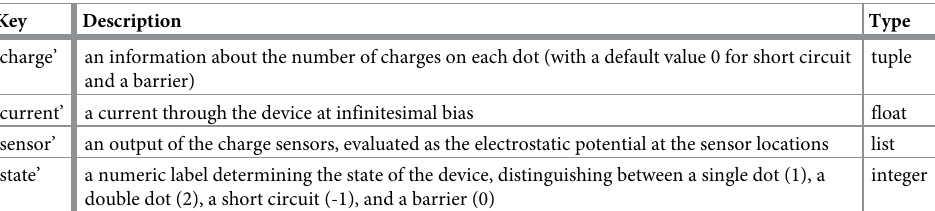
Table 2. The single device simulation output (stored as ‘output’) is a list of 10 000 dictionaries, holding the simu- lated data for each point in the plunger voltage space (defined by vectors ‘V_P1_vec’ and ‘V_P2_vec’). The ‘output’ dictionaries include four variables, as defined in the